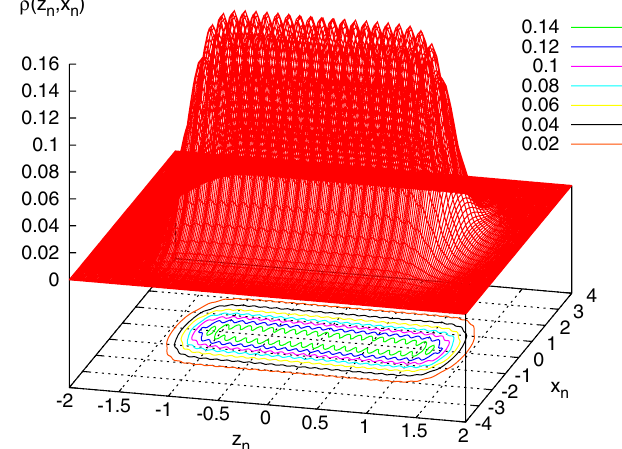
FIG. 7. Normalized charged density distribution for the flattop distribution with A ¼ 0 : 05 and (cid:8) ¼ 100 (cid:9) m . The other parame- ters are given in Table